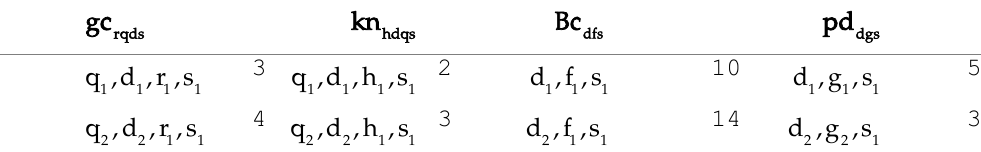
Table 6. Flow of relief personnel, injured, earthquake victims and corpses.